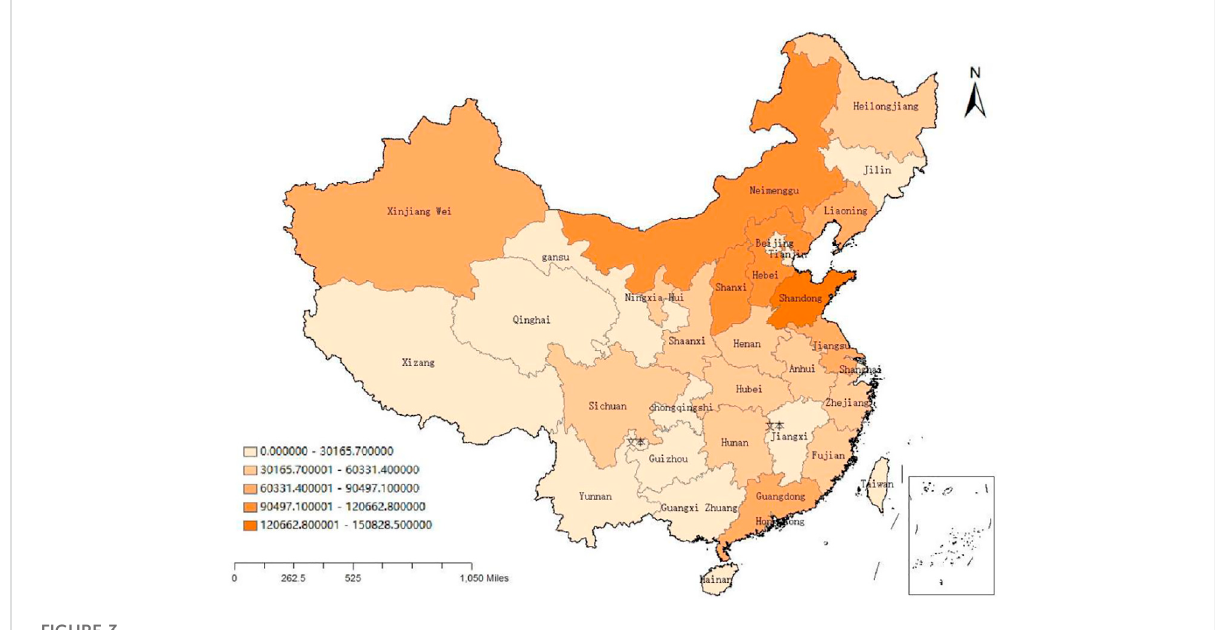
FIGURE 3 2019 Carbon emissions distribution